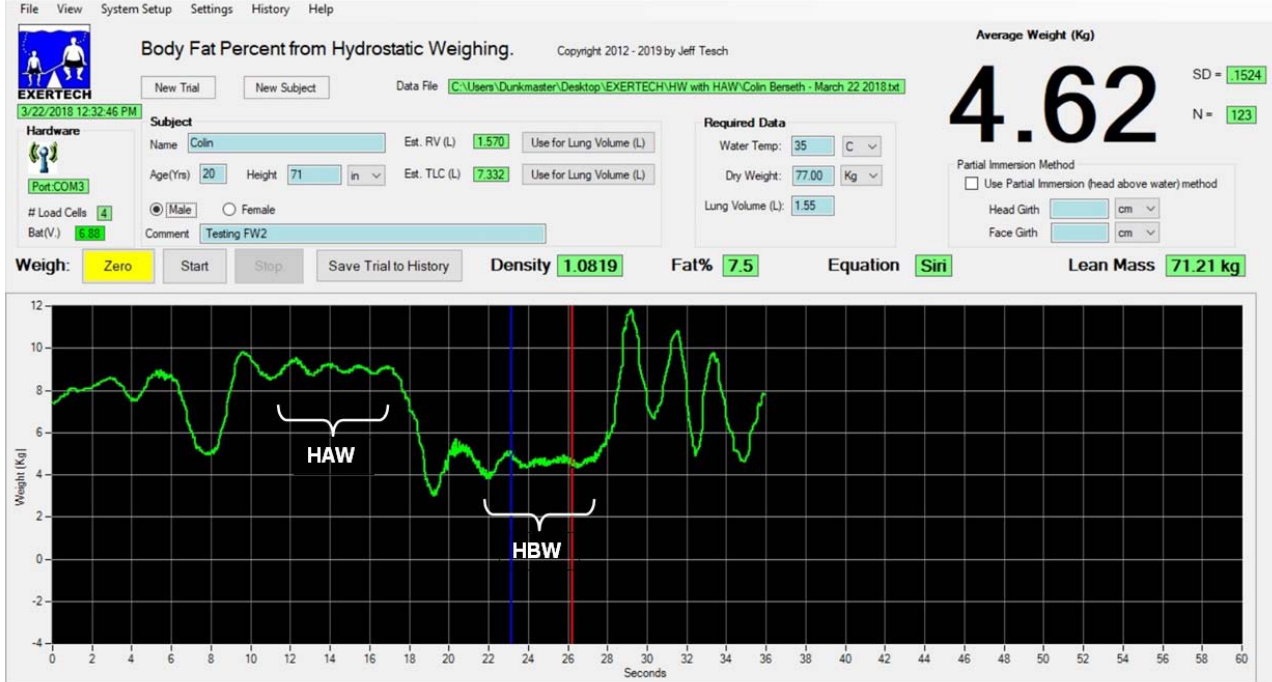
Figure 3. Screen capture of the weighing software showing head above water (HAW) and head below water (HBW) regions of a hydrostatic weighing trial.